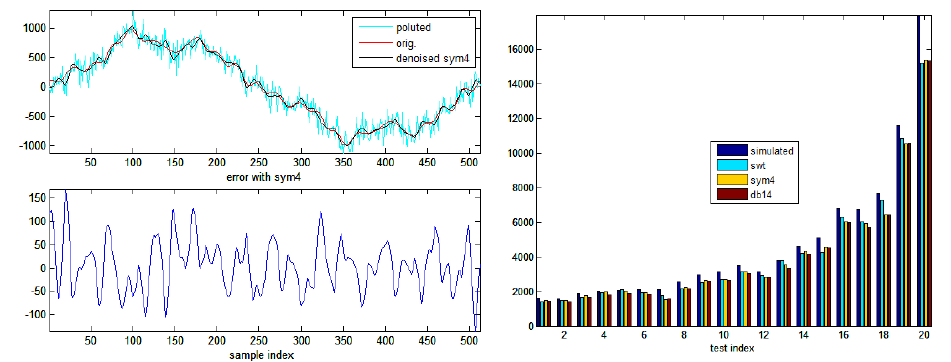
Figure 12. Simulated and computed noises pow- ers considering the SWT based technique with both wavelet mother functions, 1-st data set.